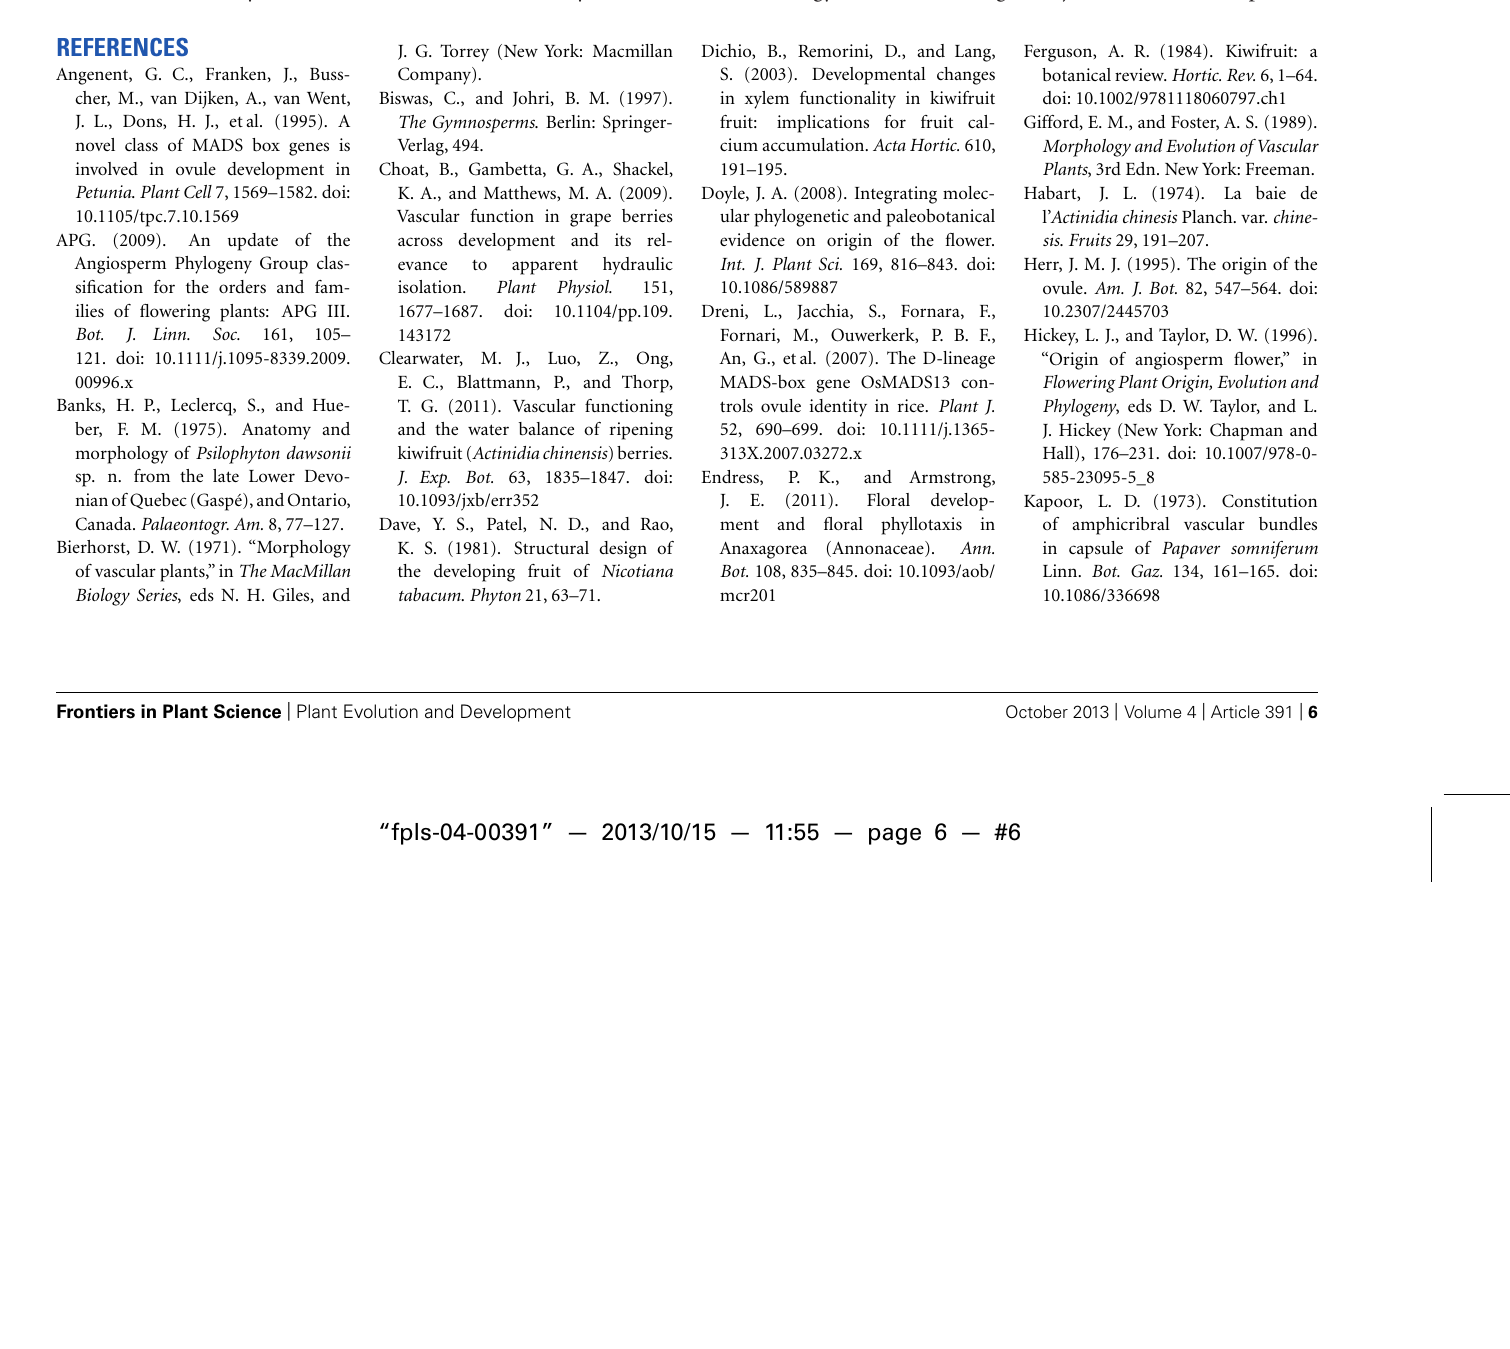
vascular bundles (green dots) in the fruit. Note septum vascular bundles occur in every other septum. CB, central placenta vascular bundle; LB, lateral branch bundle; PB, placental vascular bundle; OB, ovary wall vascular bundle; OT, ovule trace; SB, septum vascular